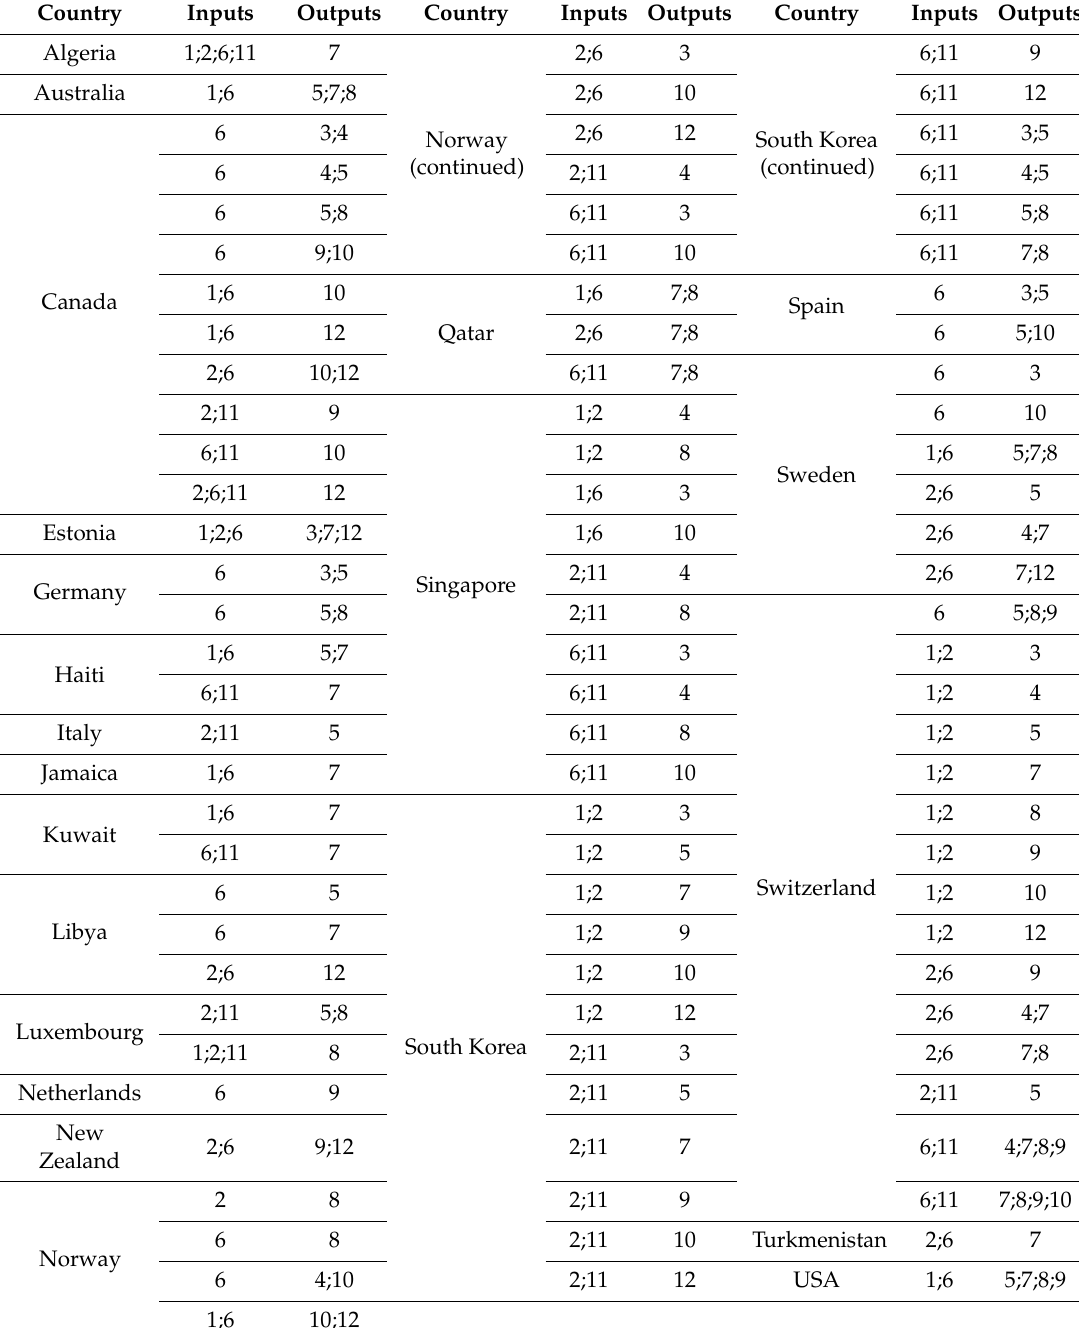
Table 4. Minimal subsets of indicators (e ffi ciency reducts) that make the corresponding country e ffi cient. The numbers refer to the indicator number listed in Table 2. The full table for all e ffi cient countries is available in the electronic supplementary information (ESI), Table